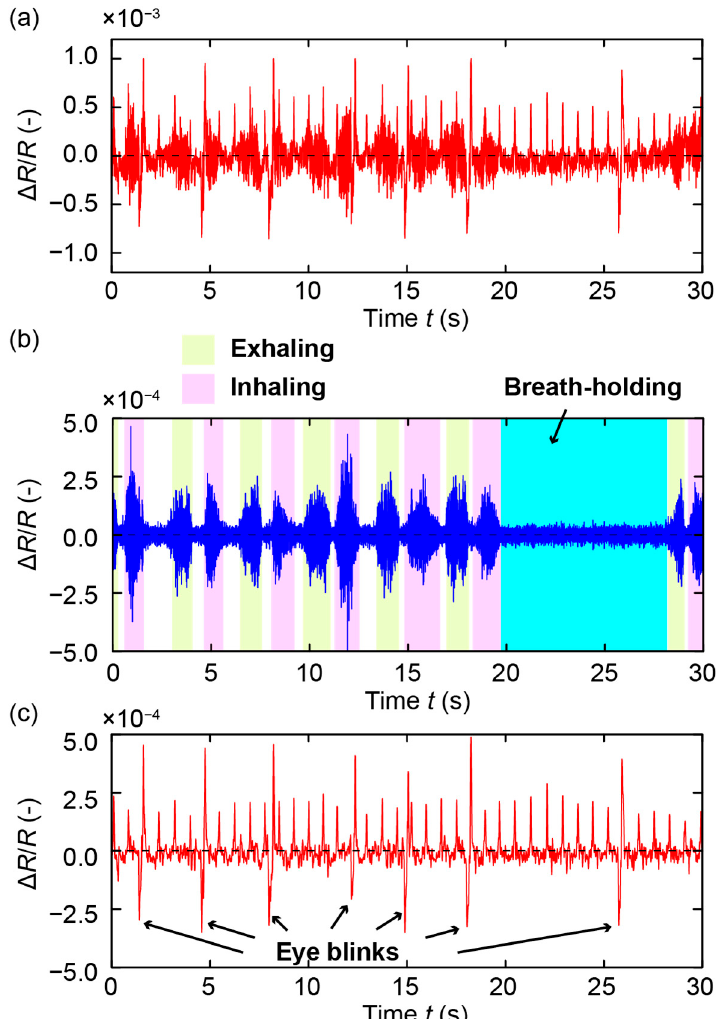
Figure 5. Measurement results in the case of nose breathing. ( a ) Sensor raw signal. ( b ) High-pass- filtered signal corresponding to the respiration of the subject. ( c ) Processed signal showing the pulses and eye blinks of the subject.